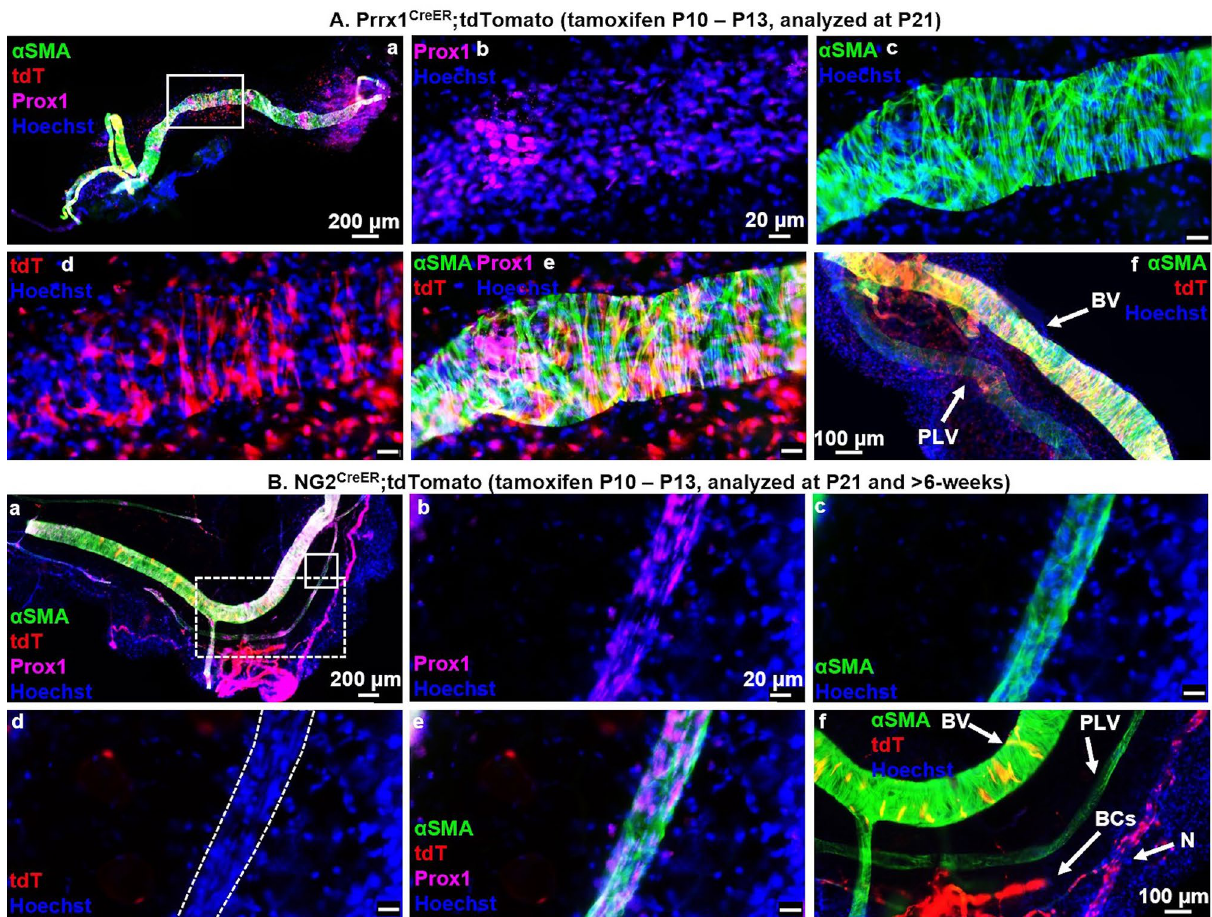
Figure 4. PLV-LMCs derive from a unique Prrx1 + and NG2 − progenitor cell incorporated onto PLVs between P10 and P21. Multicolor fluorescent microscopy was performed on whole mount immunostained PLVs and adjacent blood vessels (BVs) from tamoxifen-inducible Prrx1 CreER (n = 6, P21 depicted), and NG2 CreER (n = 5, P90 depicted) reporter mice as described in Fig. 1. Representative low-magnification overlay images of all channels show the PLVs with a highlighted region of interest (white boxes) ( A.a , B.a ). High-magnification images of the region of interest show Prox1 immunostain of LECs ( A.b , B.b ), αSMA immunostain of LMCs ( A.c , B.c ), Cre- driven tdT expression ( A.d,B.d ), overlay of all channels ( A.e , B.e ), and positive control BV VSMCs ( A.f , B.f ), blood capillary (BC) pericytes, and peripheral nerves (N) all directly adjacent to PLVs ( B.f ). Lineage tracing of Prrx1 CreER ( A.a – f ) mice demonstrates tdT expression in PLVs ( A.d ) that colocalizes with αSMA + LMCs ( A.e ) along with successful Cre-recombination with tdT expression in positive control VSMCs, as expected ( A.f ). NG2 CreER ( B.a – f ) mice show absent tdT expression in PLVs (no red fluorescence in outlined PLV) ( B.d ) with successful tamoxifen induced NG2-driven Cre-recombination depicted by tdT expression in BV VSMCs, BC pericytes, and peripheral nerves (N), as expected ( B.f ). Note the few yellow VSMCs on the BV, which indicates that these cells were added to the fully formed BV after tamoxifen